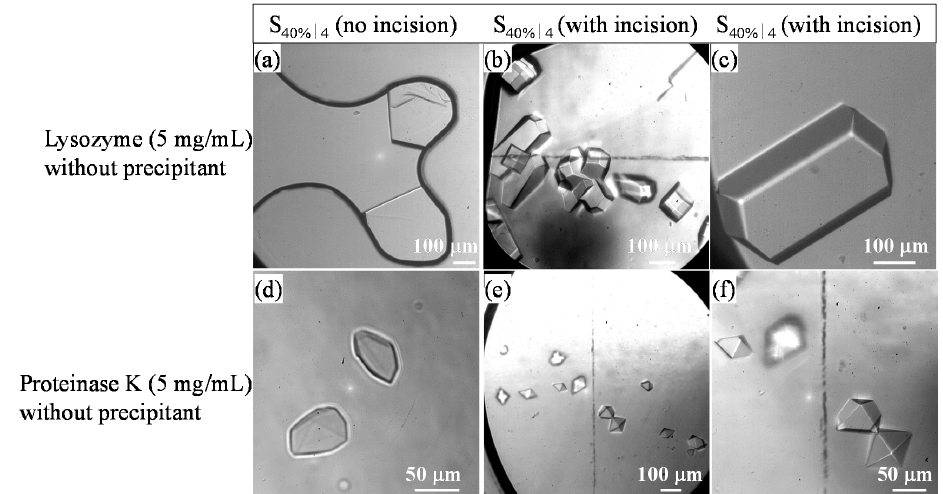
Figure 4. Optical micrographs summarize occurrence of lysozyme ( a – c ) and proteinase K ( d – f ) crystals on set III substrates. The concentration of both proteins in respective buffers was 5 mg/ml and no precipitant was used in either case. Images ( a ) and ( d ) depict the appearance of a few crystals of respective proteins on set III substrates devoid of any incision. Images ( b ) and ( e ) show appearance of large number of crystals of these proteins on set III substrates decorated with the incision. Selected portions of image ( b ) and ( e ) are magnified in images ( c ) and ( f ) to clearly show the three dimensional morphology of the crystals.